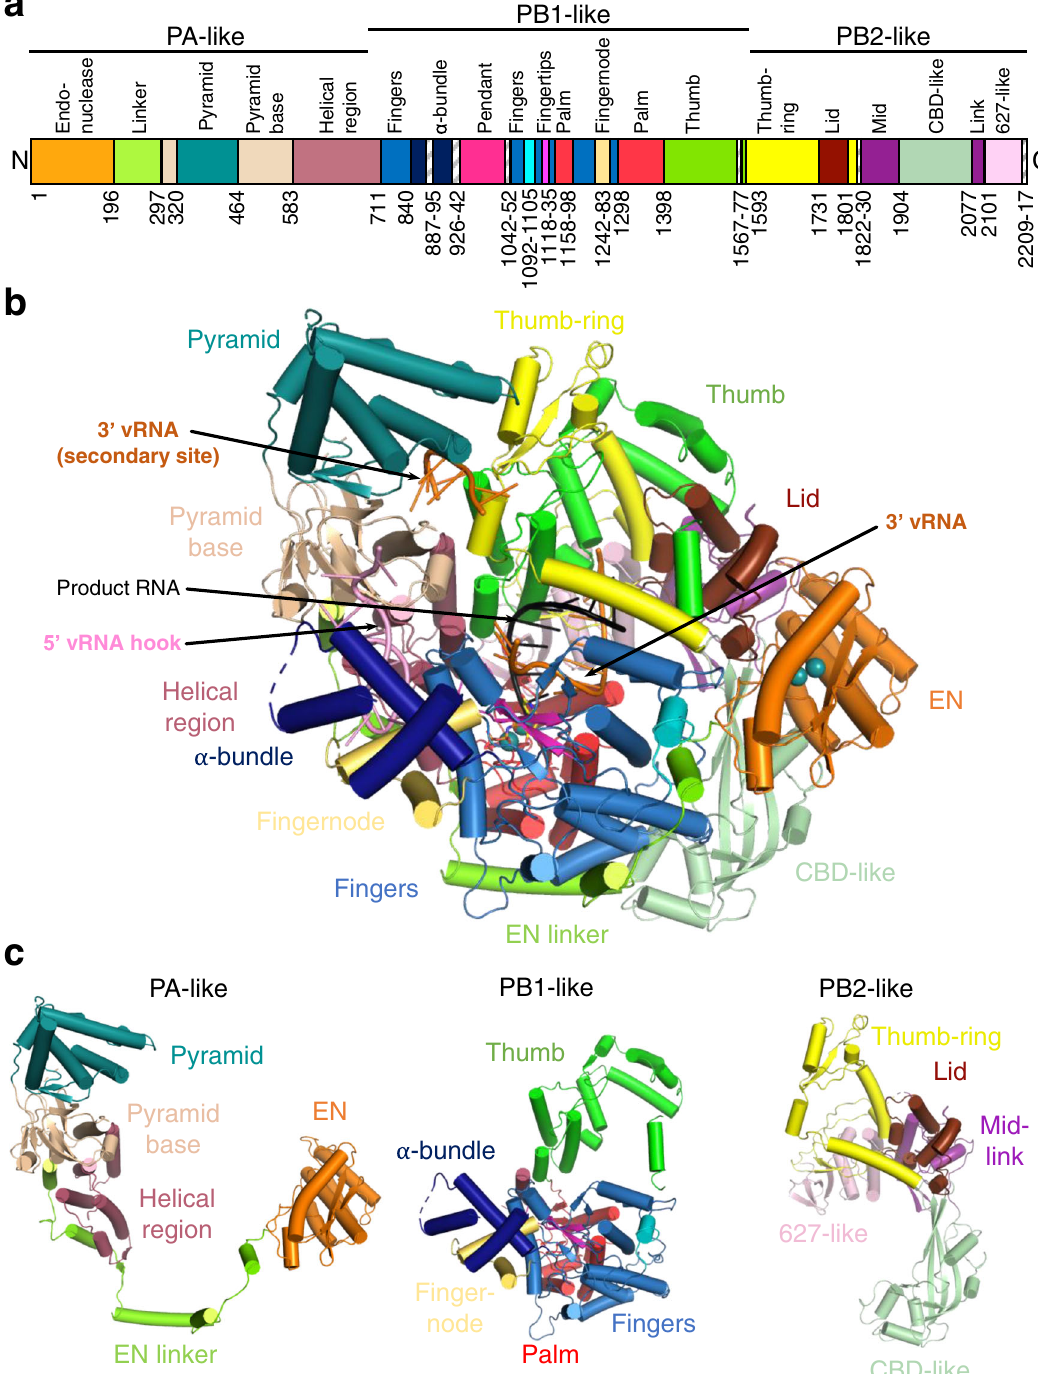
Fig. 3 Overview of the L protein structure. a Schematic linear presentation of the L protein domain structure. b Complete ELONGATION structure of the L protein presented as a ribbon diagram in front view. Domains are coloured according to ( a ) and labelled. 3 ′ vRNA is coloured in orange, 5 ′ vRNA in pink and product RNA in black. See also Supplementary Movie 3 for a 3D impression of the L protein and its domains. c Separate presentation of the PA-like, PB1-like and PB2-like regions of the L protein in the ELONGATION